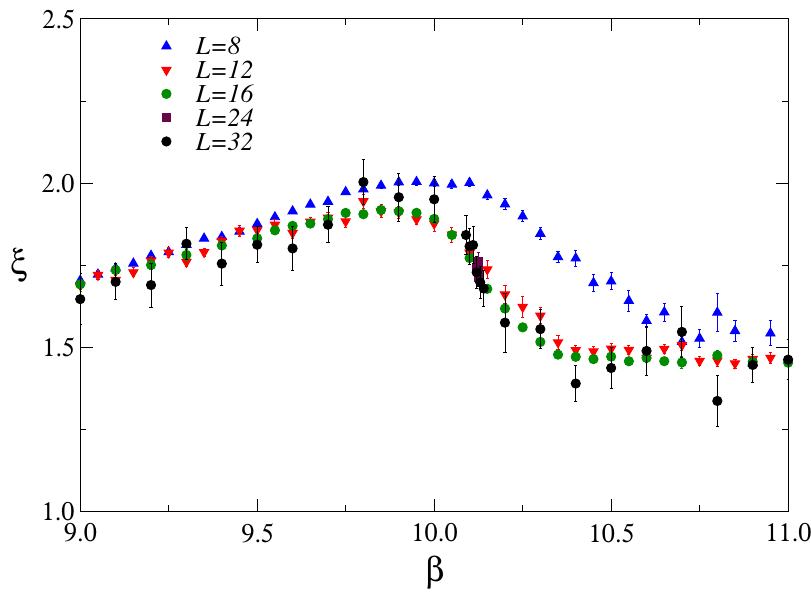
Figure 4 . Plot of ξ versus β for N c = 3 , N f = 3 , γ = 0 , and v = 1